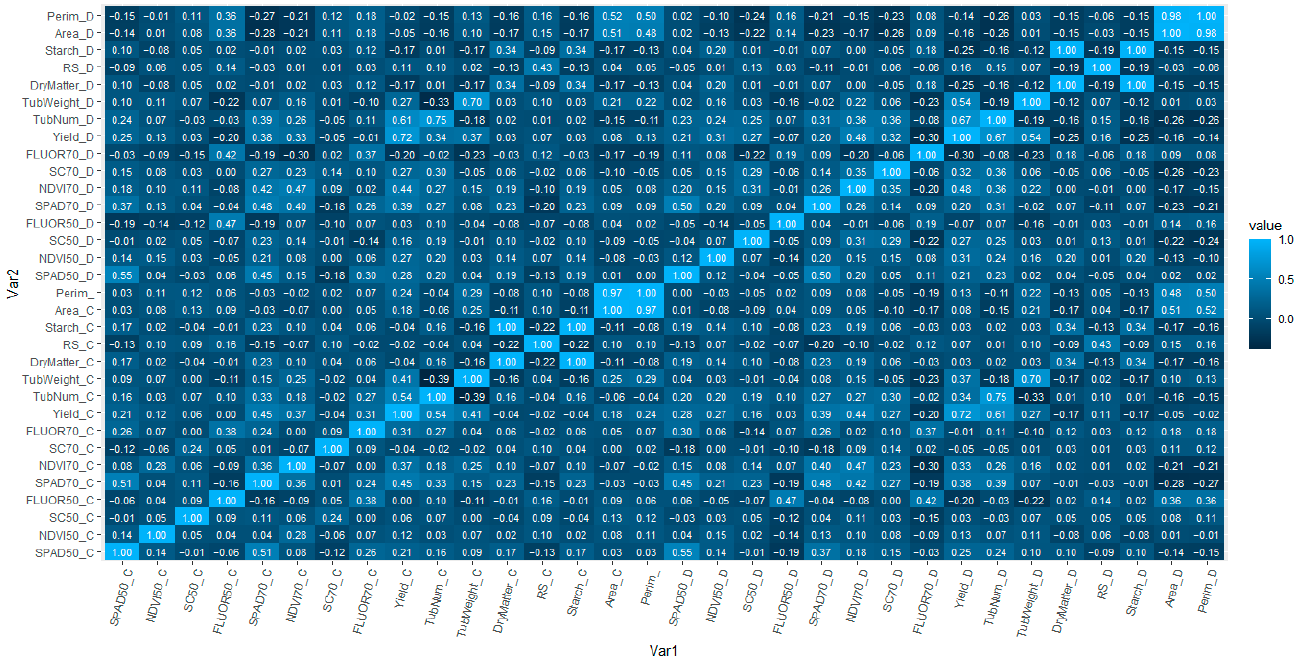
Figure 1. Pearson’s correlations between different physiological and agronomical traits under control (indicated with postfix “_C”) and water stress conditions (indicated with postfix “_D”) in a panel of 144 potato varieties. Table 2. Number of SNPs per chromosome before and after filtering and size of each chromosome. CH01 to CH12 refers to each of the 12 potato chromosomes, CH00 are control markers that are not associated with any chromosome and CH13 refers to the